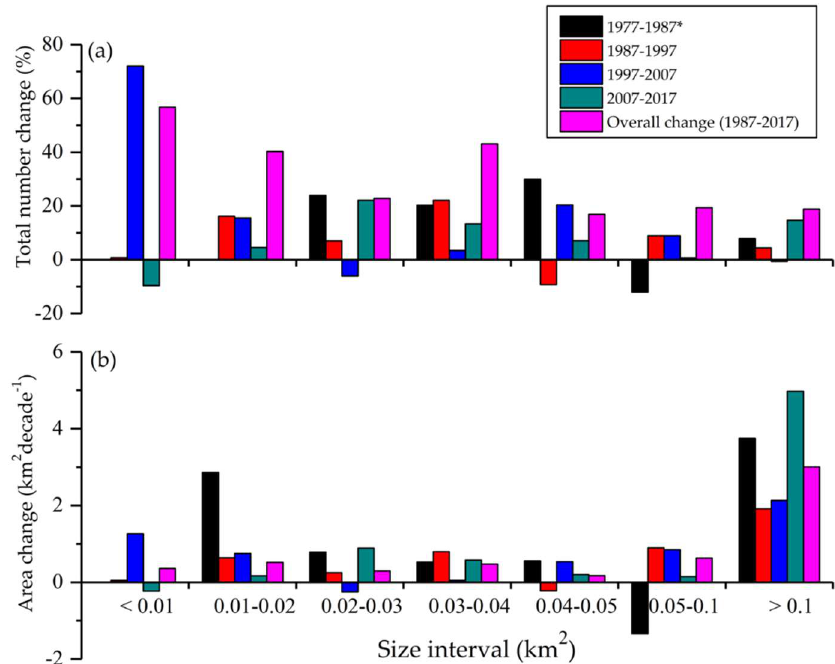
Figure 6. Decadal and overall changes in the ( a ) total number (%) and ( b ) area (km 2 decade − 1 ) of different size class of glacial lakes. * Use of coarse resolution Landsat MSS data in 1977.